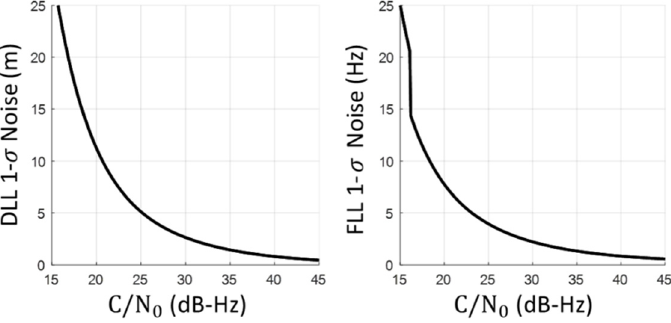
Figure 5. The 1-sigma measurement noise on DLL and FLL corresponding to the C / N 0 value.